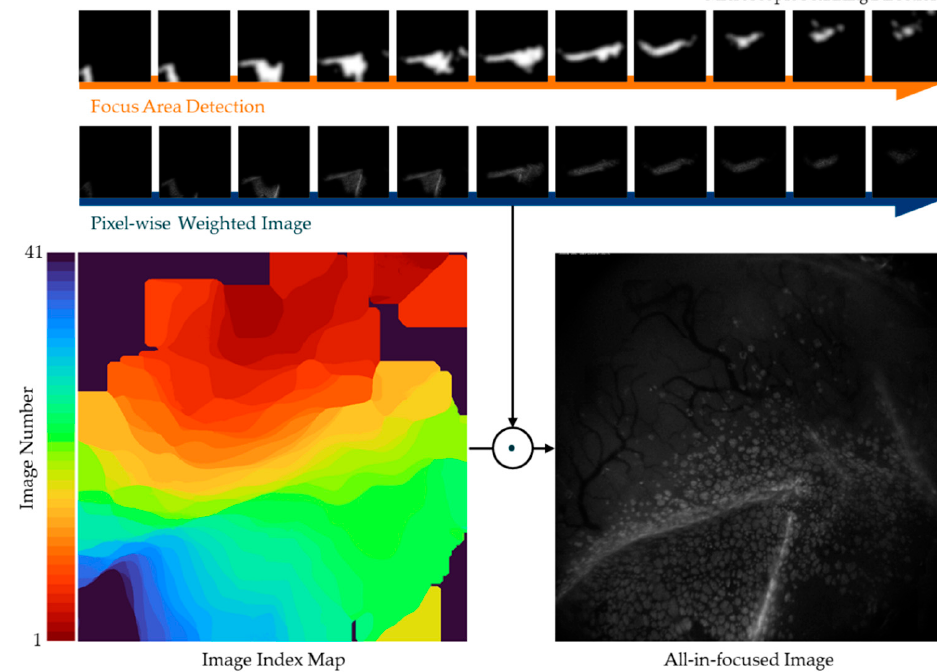
Figure 1. Schematic diagram of the proposed method.